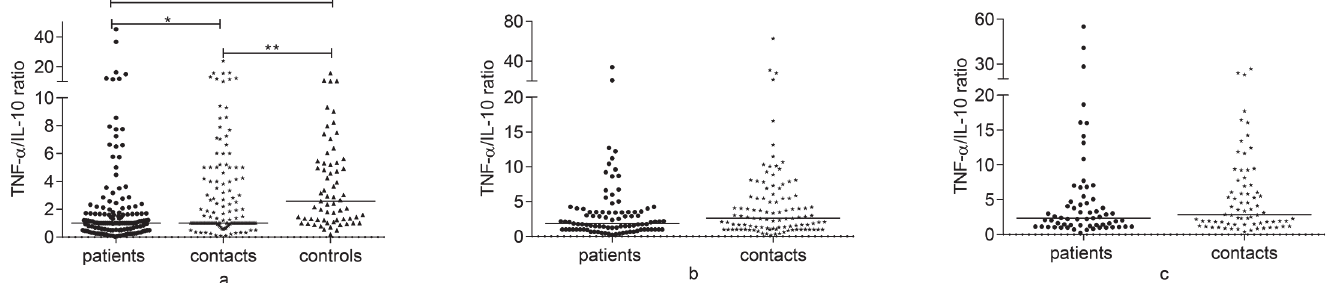
Fig 8. Comparison of TNF- α /IL-10 ratio among groups at baseline, 6 and 12 months. TNF- α /IL-10 ratio at baseline (a), 6 months (b) and 12 months (c) following whole blood stimulation with Rv2031 for 48 hours. Filled circles represent patients, filled diamonds represent contacts and filled triangles represent controls. Results are individual responses. Horizontal bars are medians. Kruskal-Wallis test with Dunn ’ s multiple comparisons (a) and Mann-Whitney test (b and C) were used to compare groups. * p = 0.03, ** p < 0.01, **** p < 0.0001.